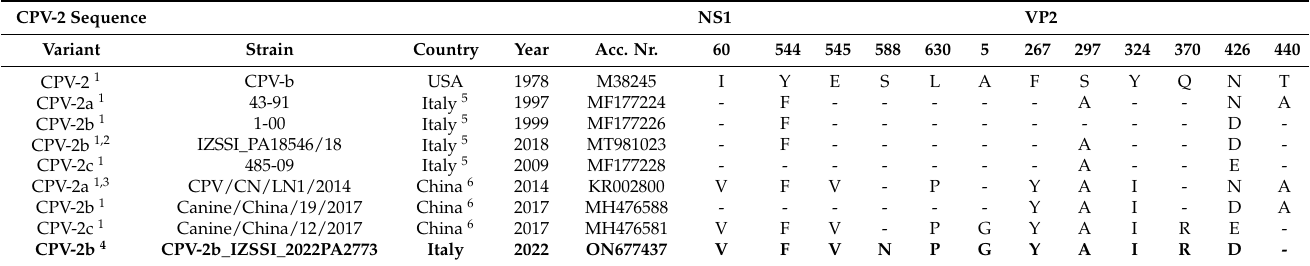
1 Reference strains; 2 collected in the same region as the strain from this study; 3 strain belonging to Asian CPV-2c-like clade; 4 strain analyzed in this study; 5 European or 6 Asian CPV-2 reference strains; ‘-’ same amino acid as in the first row. The last row was bolded to highlight data and features of the analysed